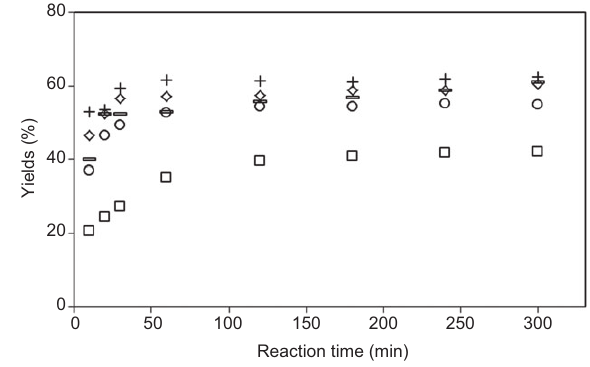
Figure 4 Comparison of the chemical yield of 3-phenylglycidol in the epoxidation reaction of cinnamyl alcohol in IL (cid:2) , [bmim][Tf and (cid:3) , toluene [3 mol% VO(acac)